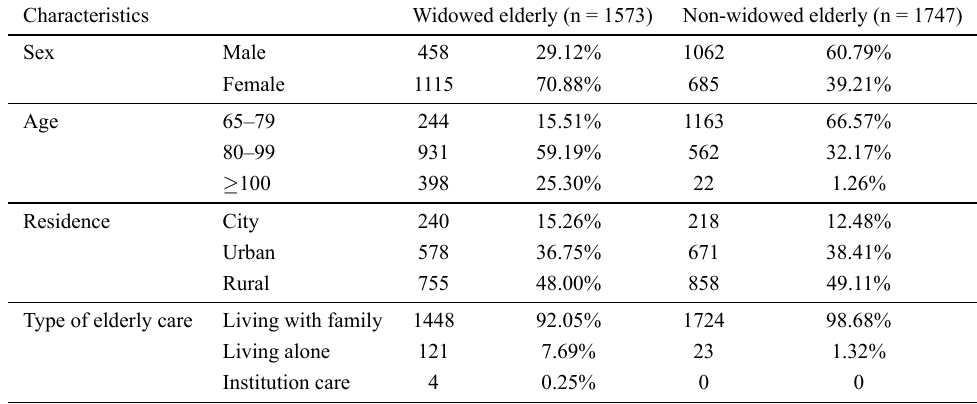
Table 2. Descriptive statistics of the sample (n = 3320).